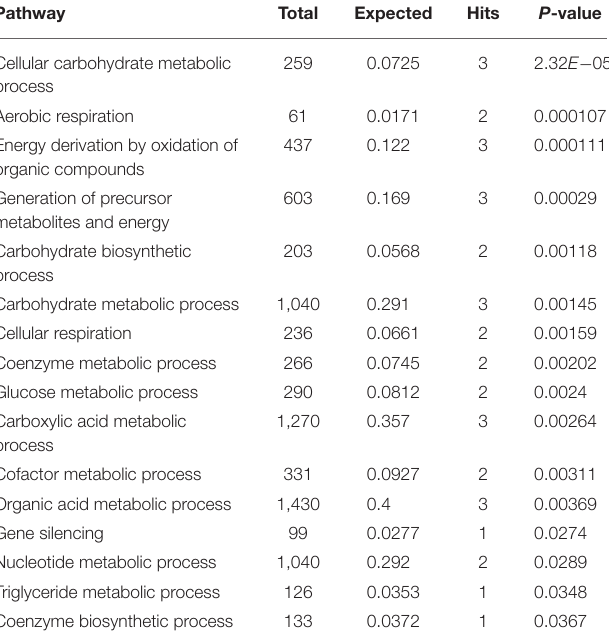
TABLE 2 | Pathways enriched by proteins and metabolites in subnetwork 2 of the protein–metabolite interaction network based on the GO:BP database. Pathway